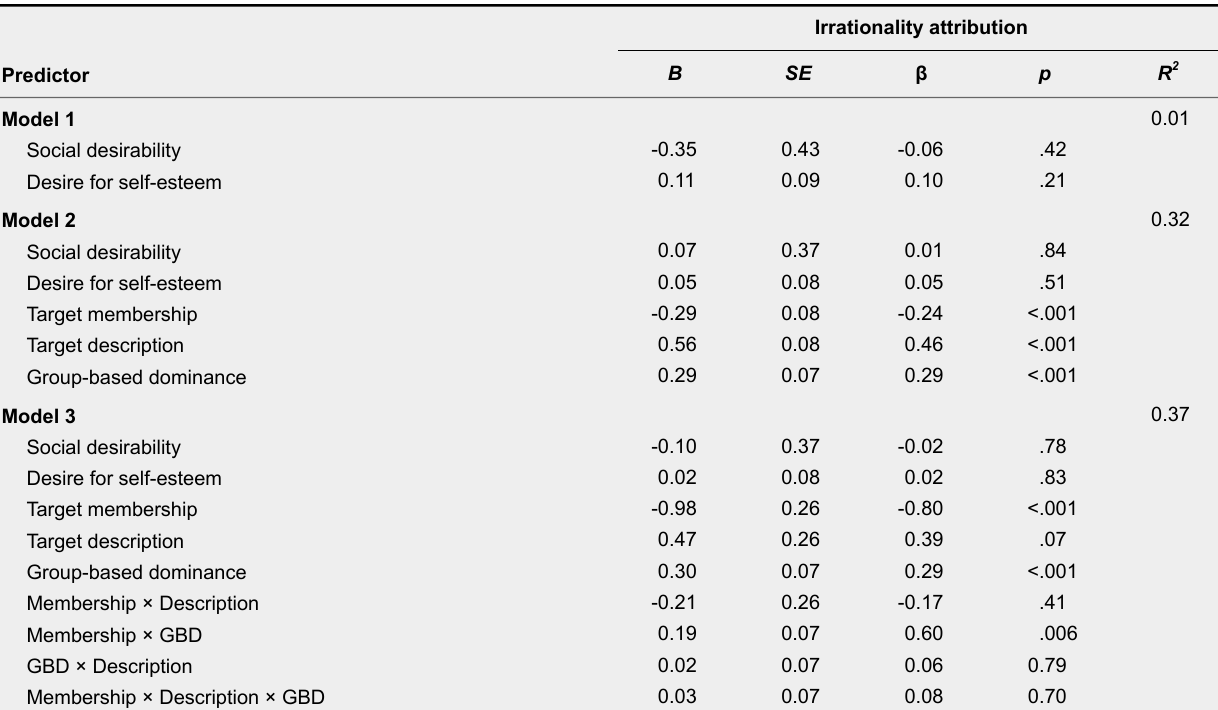
Hierarchical Multiple Regressions Analysis With Enter Method for Social Desirability, Desire for High Self-Esteem, Group-Based Dominance, Description of the Target Person(s), Target Person’s Group Membership, and Interactions Effects, Predicting Irrationality Attribution in Study